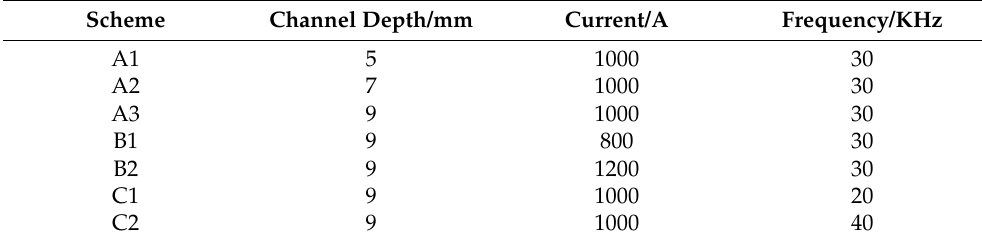
Table 1. Simulation experiment scheme of induction heating.